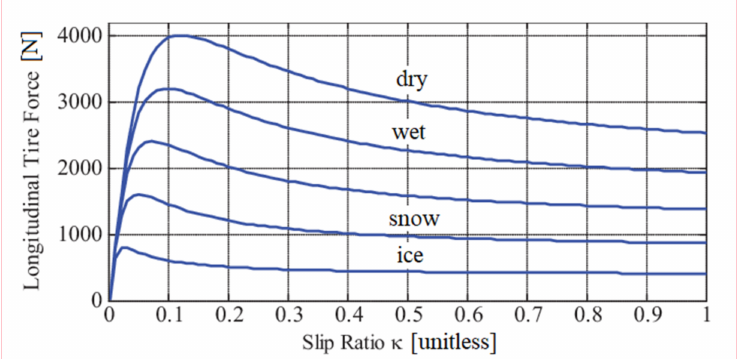
Figure 1. Dependence of longitudinal wheel force on the wheel slip ratio for di ff erent conditions of the road surface